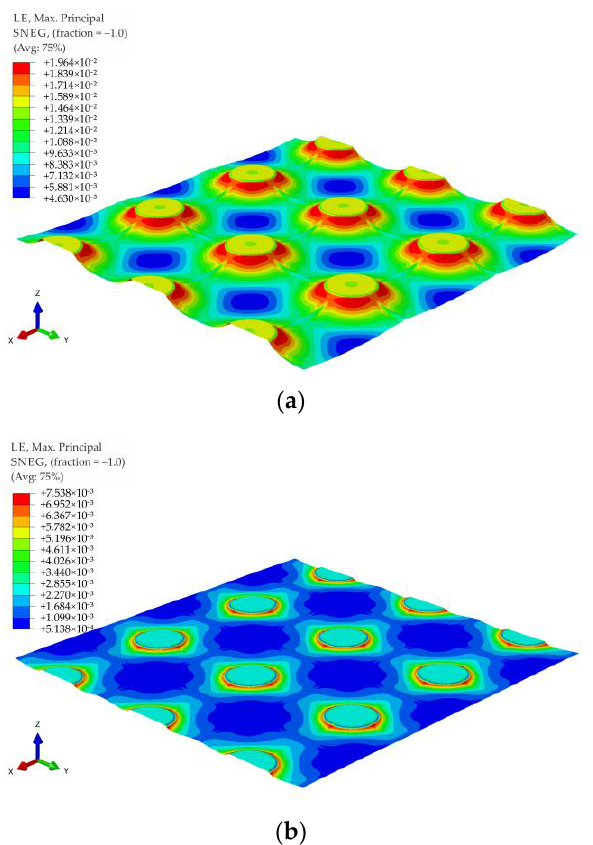
Figure 34. Deformation and maximum principal strain in reinforcement for inverse pyramid shape load distribution, variant B2: ( a ) k = 0 kN/m 3 ; ( b ) k = 500 kN/m 3 .